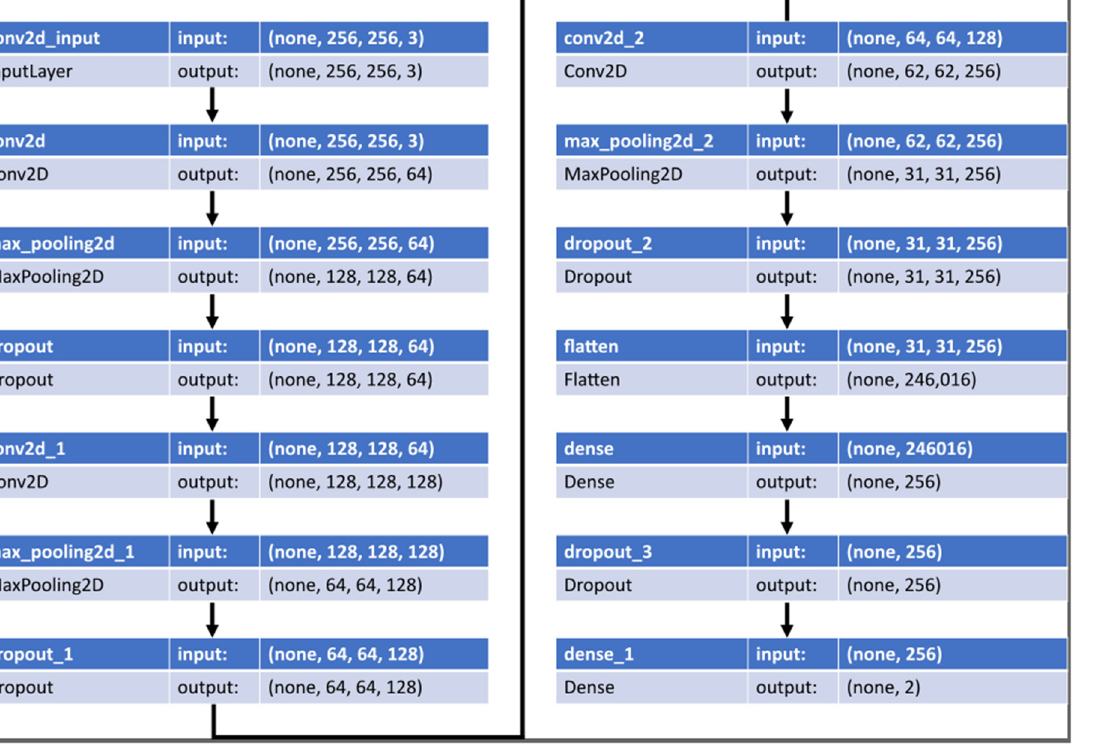
used as the performance evaluation